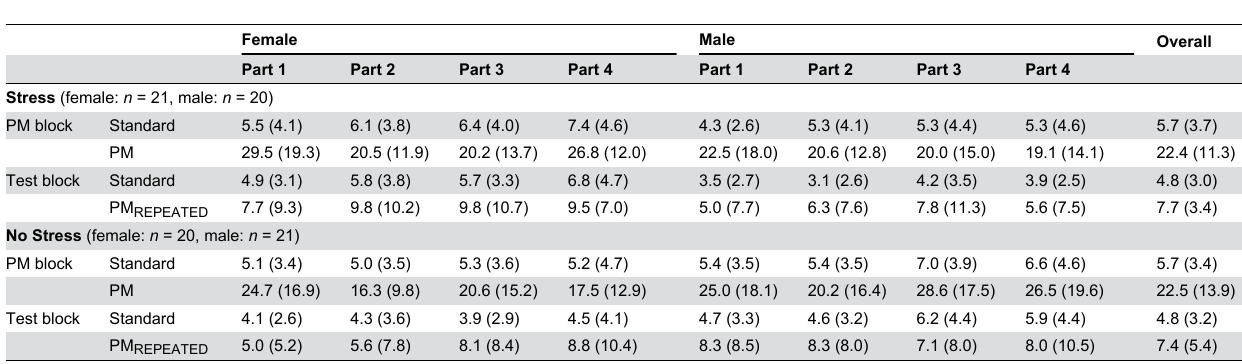
Table 2. Mean Error Rates (in %) for the PM Block and the Test Block by Trial Type (PM Block: Standard, PM; Test Block: Standard, PM ) and Treatment (Stress, No Stress), and with the Additional Factors Sex (Female, Male) and Time REPEATED (Part 1 to Part